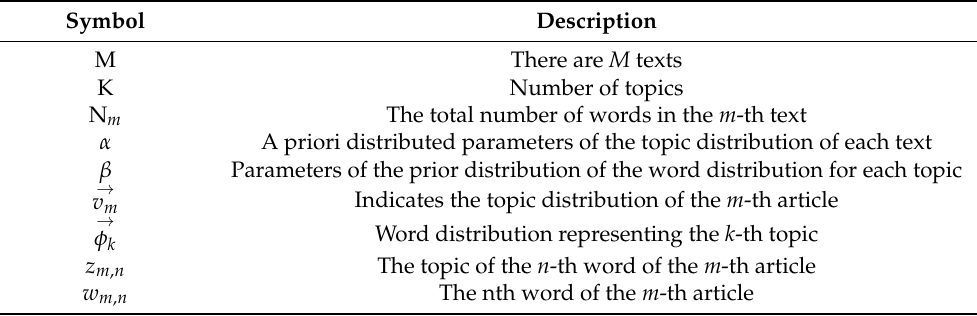
Table 3. Symbol representation of the LDA topic model.